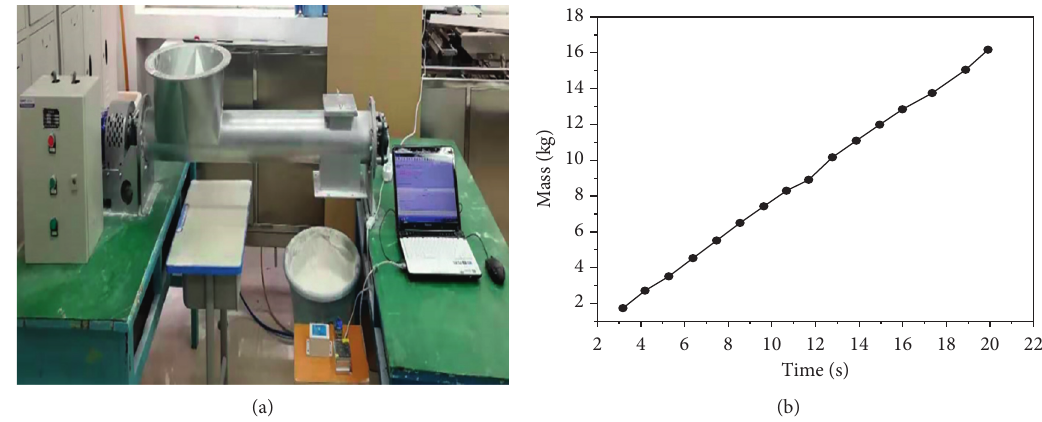
Figure 4: Determination of mass flow rate of wheat flour screw conveyor. (a) Mass flow rate experiment of wheat flour. (b) Time-mass curve